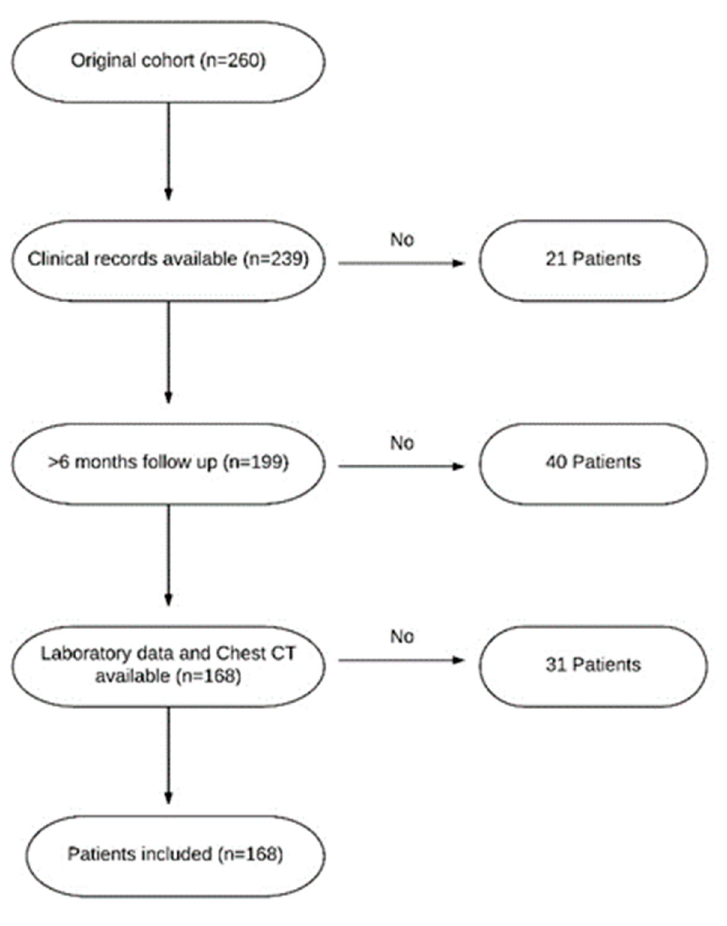
Figure 1. Inclusion and exclusion criteria for study enrollment. CT: chest tomography. The preferential “respiratory-limited phenotype” was defined as the presence of lung involvement (lung infiltrates) without constitutional symptoms (persistent fever >38 °C, night sweats, unexplained weight loss) or skin, heart, joints, kidney and Central/Peripheral Nervous System (CNS/PNS) involvement. Conversely, the presence of constitutional symptoms and/or organ involvement, in addition to lung involvement, defined the “systemic phenotype” (lung plus extra-pulmonary disease). We did not include asthma and CRSwNP in the logistic regression model because they were present in all and almost all patients, respectively. Clinical involvement was assessed by the treating physicians at baseline and during the clinical